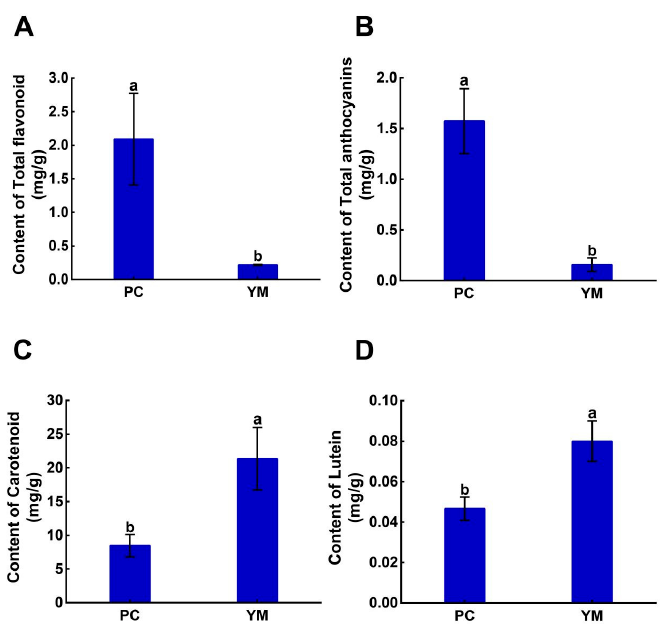
Figure 5. The content of pigments in the ray florets of PC and YM. The content of total flavonoids ( A ), total anthocyanins ( B ), carotenoids ( C ), and lutein ( D ) in ray florets of PC and YM. Different letters indicate significant differences at p < 0.05 according to Duncan’s multiple range test.